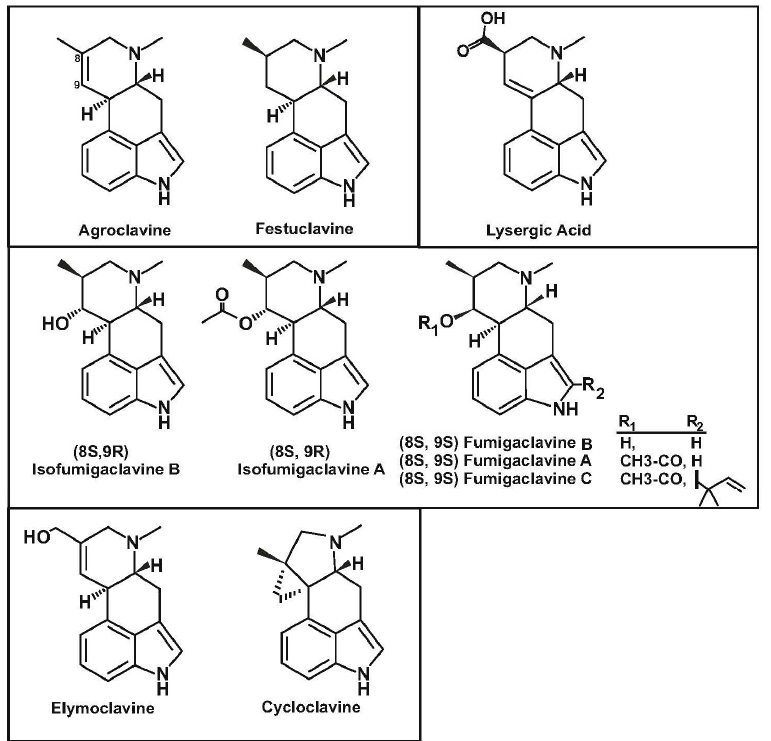
Figure 1. The chemical structures of agroclavine, festuclavine and lysergic acid ( upper panel ). (8S, 9R) isofumigaclavines A and B and (8S, 9S) fumigaclavines A, B and C ( middle panel ). Elymoclavine and cycloclavine ( lower panel ).